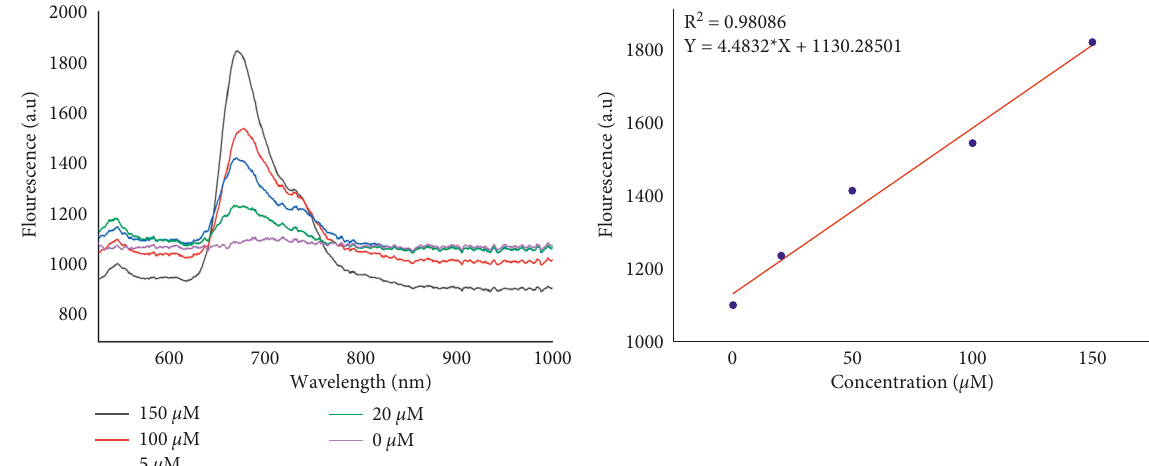
Figure 5: An example of the fluorescence spectra acquired for different concentrations of the photosensitizer in the ethanol